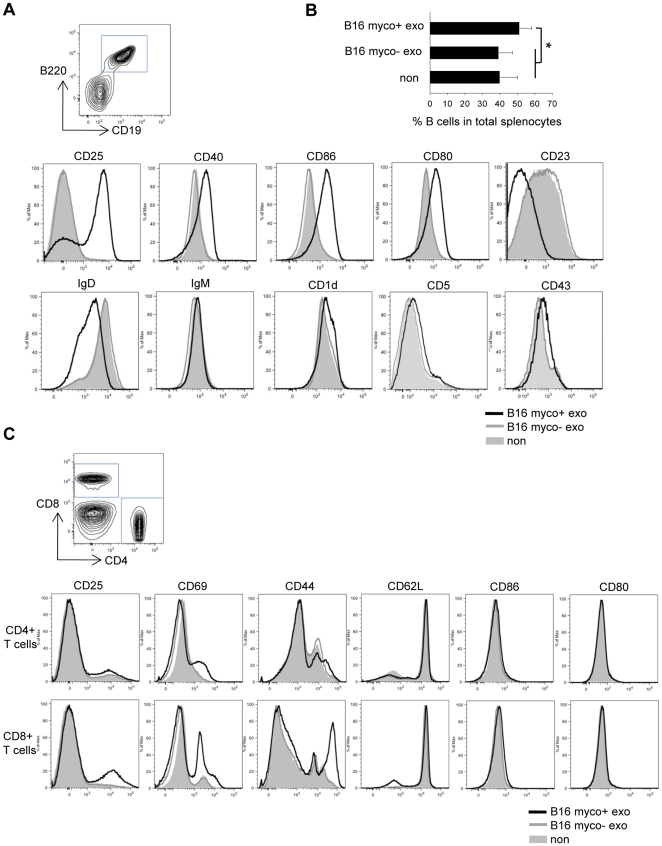
Myco+ exosomes induce B cell activation and expansion.Splenocytes were treated with 1 µg/ml of B16 myco+ exosomes or B16 myco− exosomes, or cultured untreated for 72 hr. Cells were harvested and analyzed by FACS. (A) Expression of CD25, CD40, CD86, CD80, CD23, IgD, IgM, CD1d, CD5 and CD43 in the B cell gate (CD19+B220+). (B) Percentage of B cells in total splenocytes within the live cell gate after exosome treatment. Data represents the mean ± SD of four independent experiments. Significance at: *, P<0.05. (C) Expression of CD25, CD69, CD44, CD62L, CD80 and CD86 in the CD4+ T cell gate and the CD8+ T cell gate. Black line: B16 myco+ exosome treatment; grey line: B16 myco− exosome treatment; grey solid: untreated.